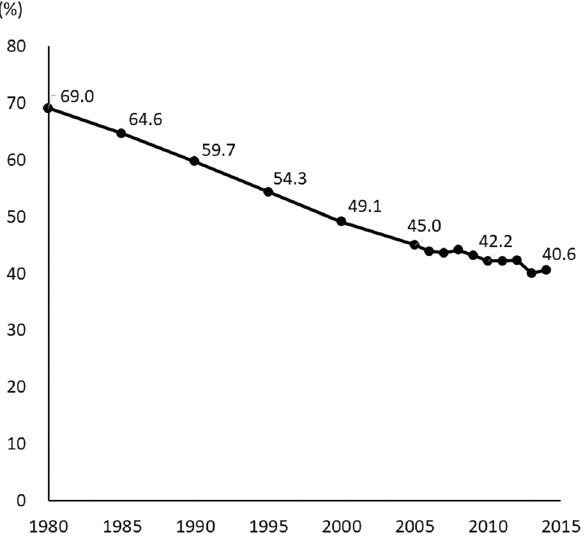
Figure 6: The ratio of women ’ s participation in the labor force ( the percentage of women participating in work among women in the workable age group ) across age groups. The Fiscal 2017 White Paper on Gender Equality, the Cabinet O ffi ce of